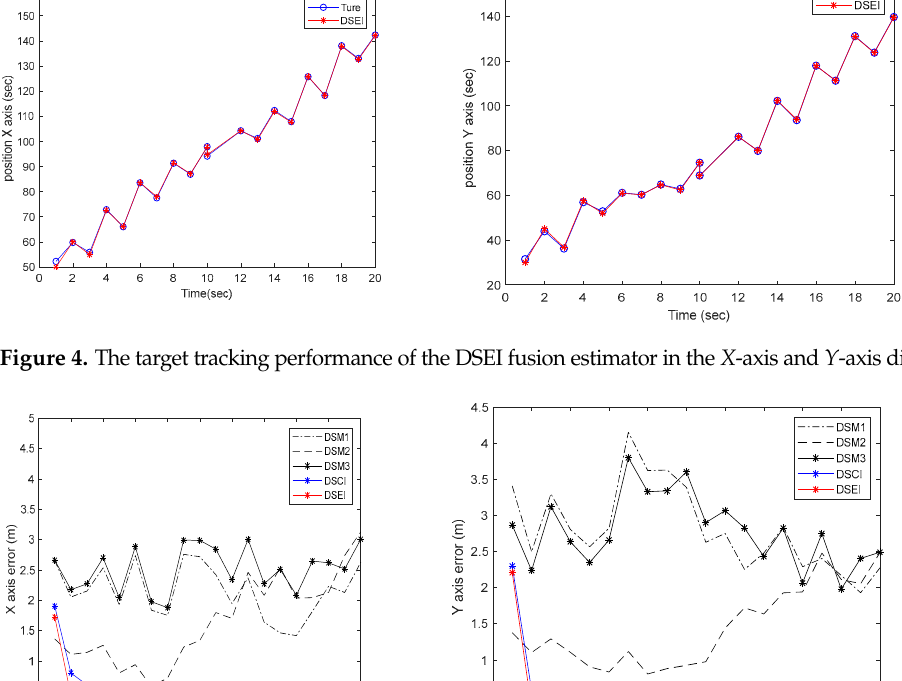
Figure 6. Comparison of the estimated ellipsoid size of the local DSM estimator with the DSCI and DSEI estimators. Meanwhile, in the simulation experiments, we analyze the computational cost of the proposed DSEI fusion algorithm. A comparison of the computational time cost of the DSCI fusion method and the DSEI fusion method during operation is shown in Figure 7. The results show that the computational cost used by the DSEI fusion estimator is smaller 0